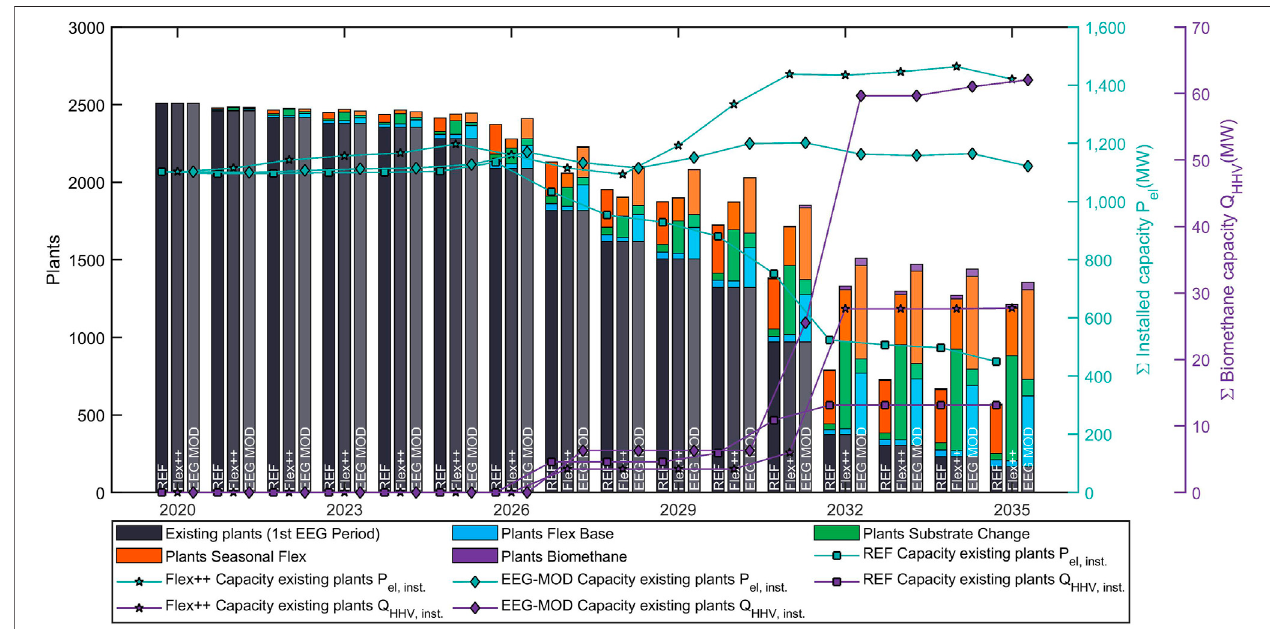
FIGURE 7 | Development of existing plants until 2035 in all three regions ( n (cid:1) 2,508) by comparing the three scenarios. Showing distribution of plant-speci fi c implemented follow-up concept, installed electric capacity, and biomethane capacity.